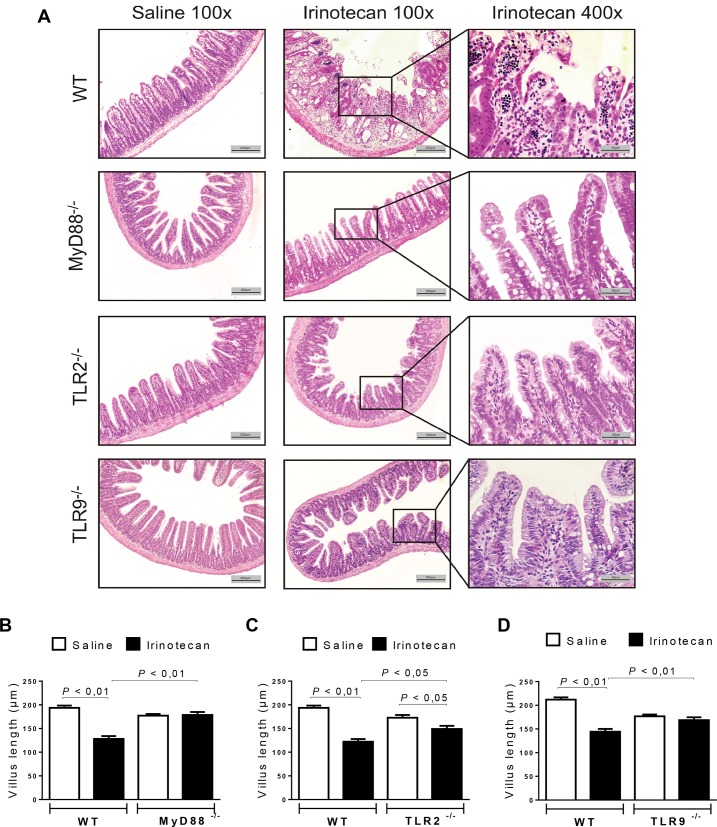
Irinotecan-induced intestinal injury is attenuated in MyD88-/-, TLR2-/- and TLR9-/- mice.The mice (n = 6–9) were injected for 4 days with saline (3 mL/kg) or irinotecan (75 mg/kg, i.p.) and were killed on the seventh day after the first dose. Ileal samples were collected and processed for histopathological and morphometric analysis. The irinotecan-treated WT animals showed a pronounced intestinal injury and inflammatory infiltration (A) and shorter villi lengths (B-D) versus the saline-treated WT group (A-D). The MyD88-, TLR2- and TLR9- knockout mice demonstrated a more intact gut architecture (A) and increased villi height (B, C and D, respectively). H&E staining. The scale bar represents 200 μm (magnification 100x) or 50 μm (magnification 400x). The values are expressed as the means ± SEM.